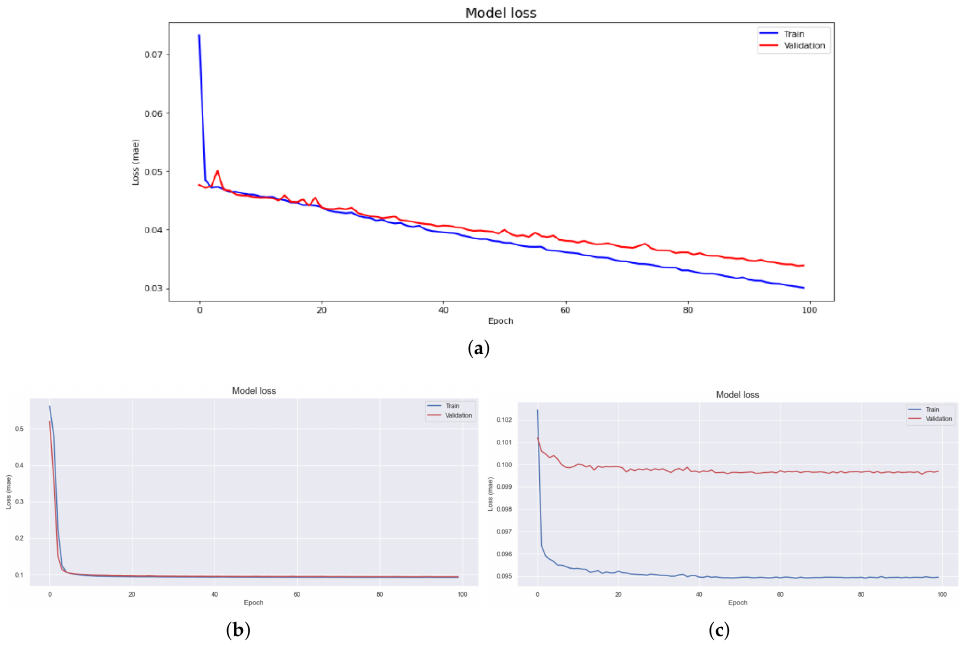
Figure 12. Loss graphs of results of using the original data, ( a ) result of using the convolutional auto-encoder, ( b ) result of using the auto-encoder LSTM, and ( c ) result of using the auto-encoder.